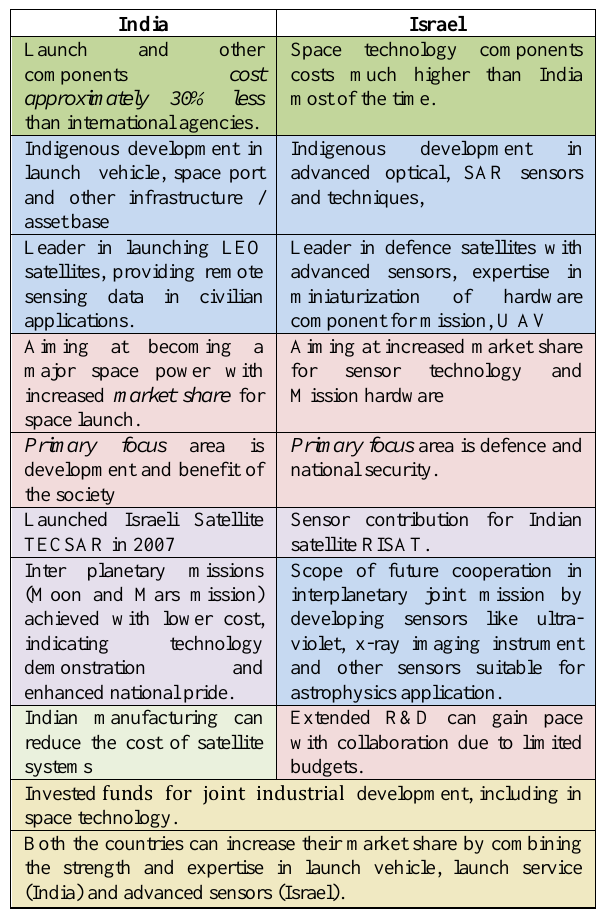
Table 4. Facts & Assumptions for India Israel Cooperation. Green – Cost related parameters, Pink - Policy parameters, Blue - Technical efficiency/capability related parameters, Lavender- Combination of more than one parameter, Yellow- Scope for joint development.